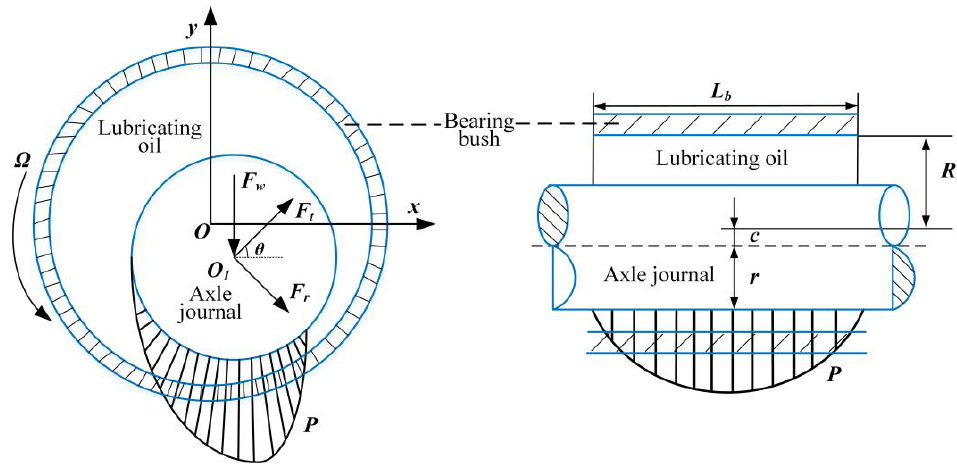
Figure 2. Description of the sliding bearing structure and its working condition.